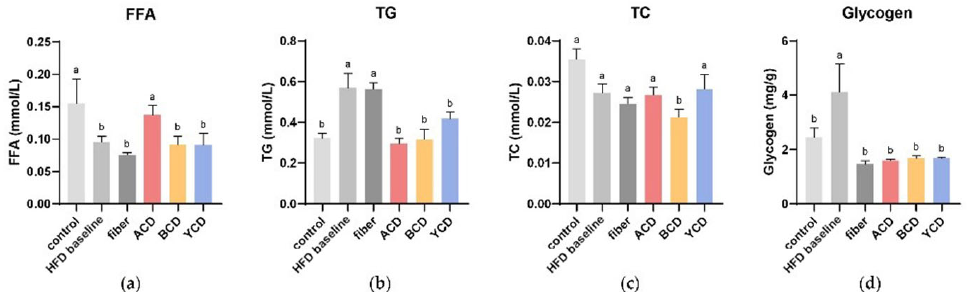
Figure 3. α -CD, β -CD, and γ -CD supplementation reduced liver glycogen and TG levels, and β -CD supplementation reduced TC levels in liver tissue. ( a ) FFA; ( b ) TG; ( c ) TC; and ( d ) glycogen content quantified in liver homogenate. n = 6. Control, low-fat diet; HFD baseline, high-fat diet without cellulose; fiber, high-fat diet; ACD, high-fat diet that replaced α -CD with cellulose; BCD, high-fat diet that replaced β -CD with cellulose; YCD, high-fat diet that replaced γ -CD with cellulose. Data are expressed as means ± SEM. Values not sharing a common superscript differ significantly among groups ( p < 0.05,